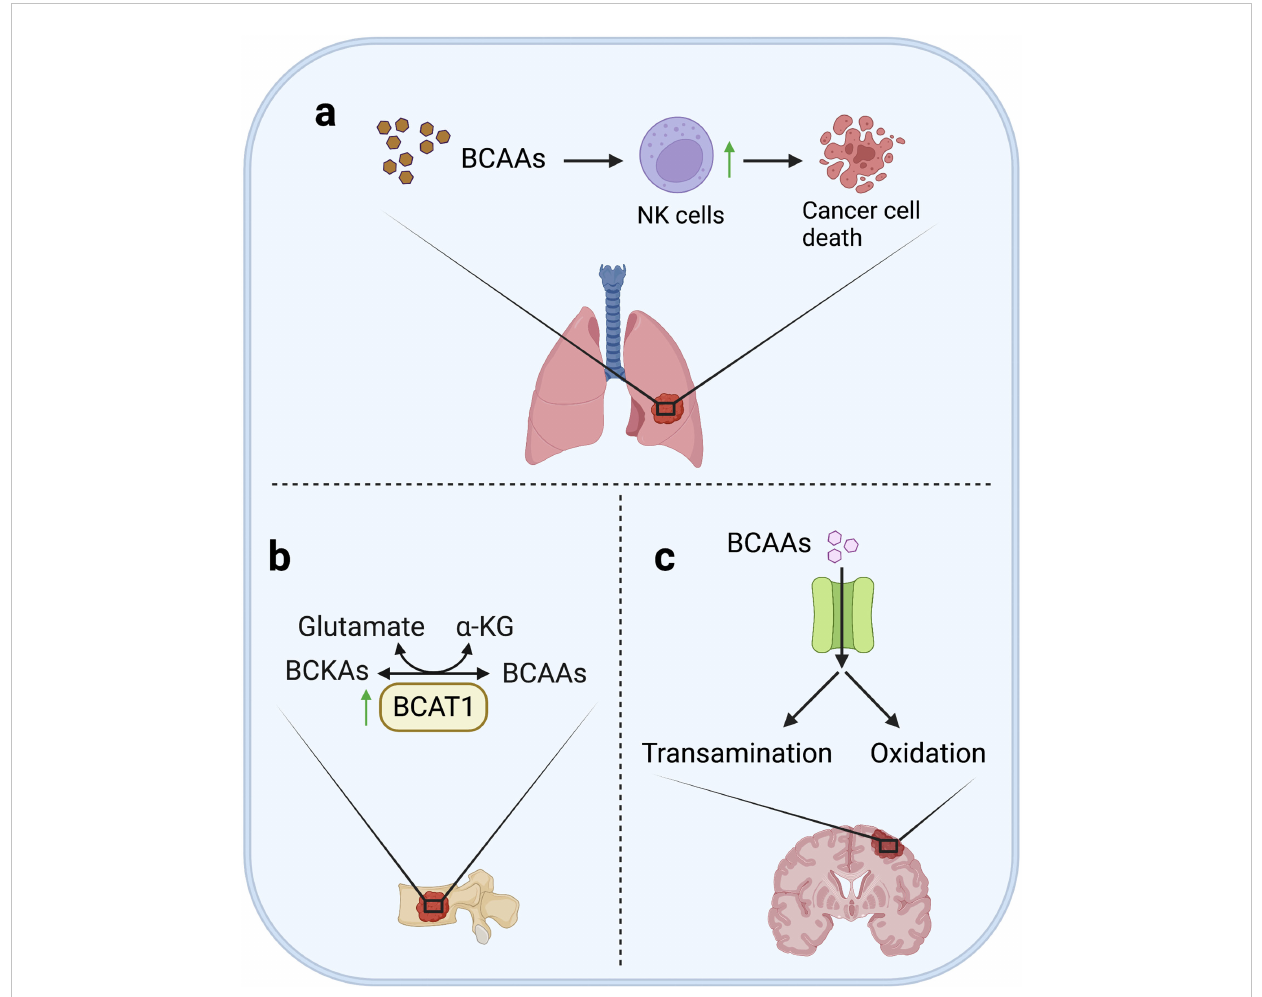
FIGURE 4 BCAAs metabolism in metastases. (A) In lung, although BCAAs are essential in supporting the proliferation and growth of various cancer, high level of BCAA may not promote formation of lung metastases, but on the contrary, high BCAA can inhibit lung metastasis of breast cancer by activating the tumor in fi ltrating-NK cells. (B) In bone, increased BCAT1 transcription can enhance BCAA catabolism to promote bone metastasis through remedy of a -KG depletion in lung cancer cells. (C) In brain, BCAAs are ingested in large quantities, and then transaminated to glutamate or oxidated for energy